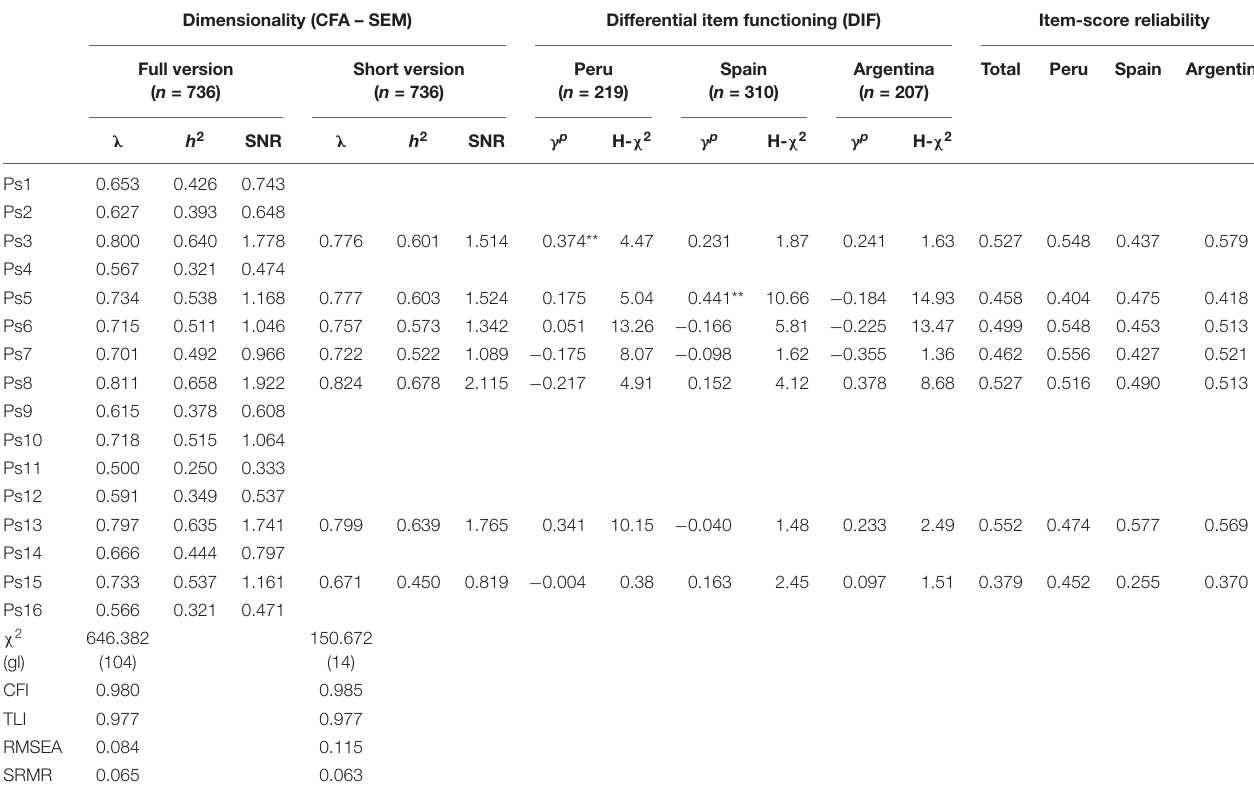
TABLE 4 | Dimensionality (CFA-SEM) and differential item functioning (DIF). Dimensionality (CFA – SEM)